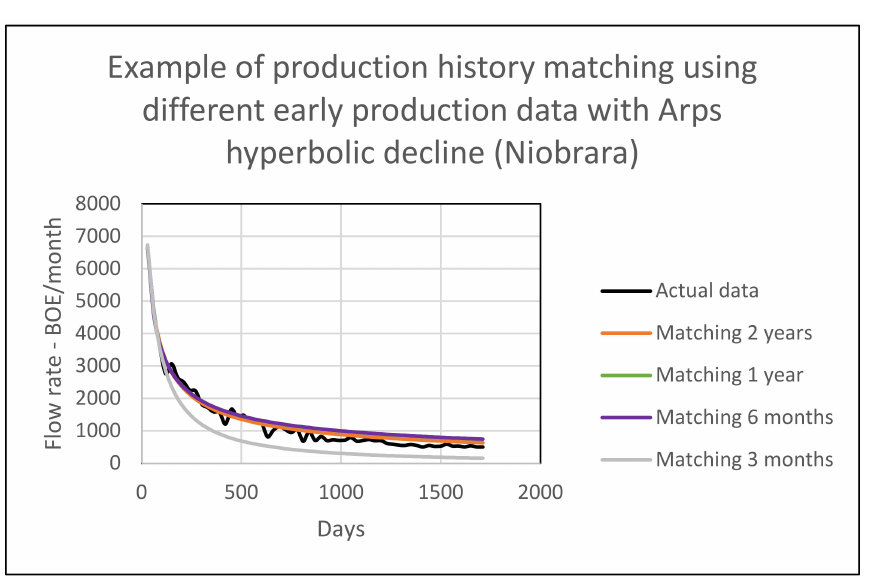
Figure 6. Example of production history matching using different production history data with the Arps hyperbolic decline model for a well in the Niobrara